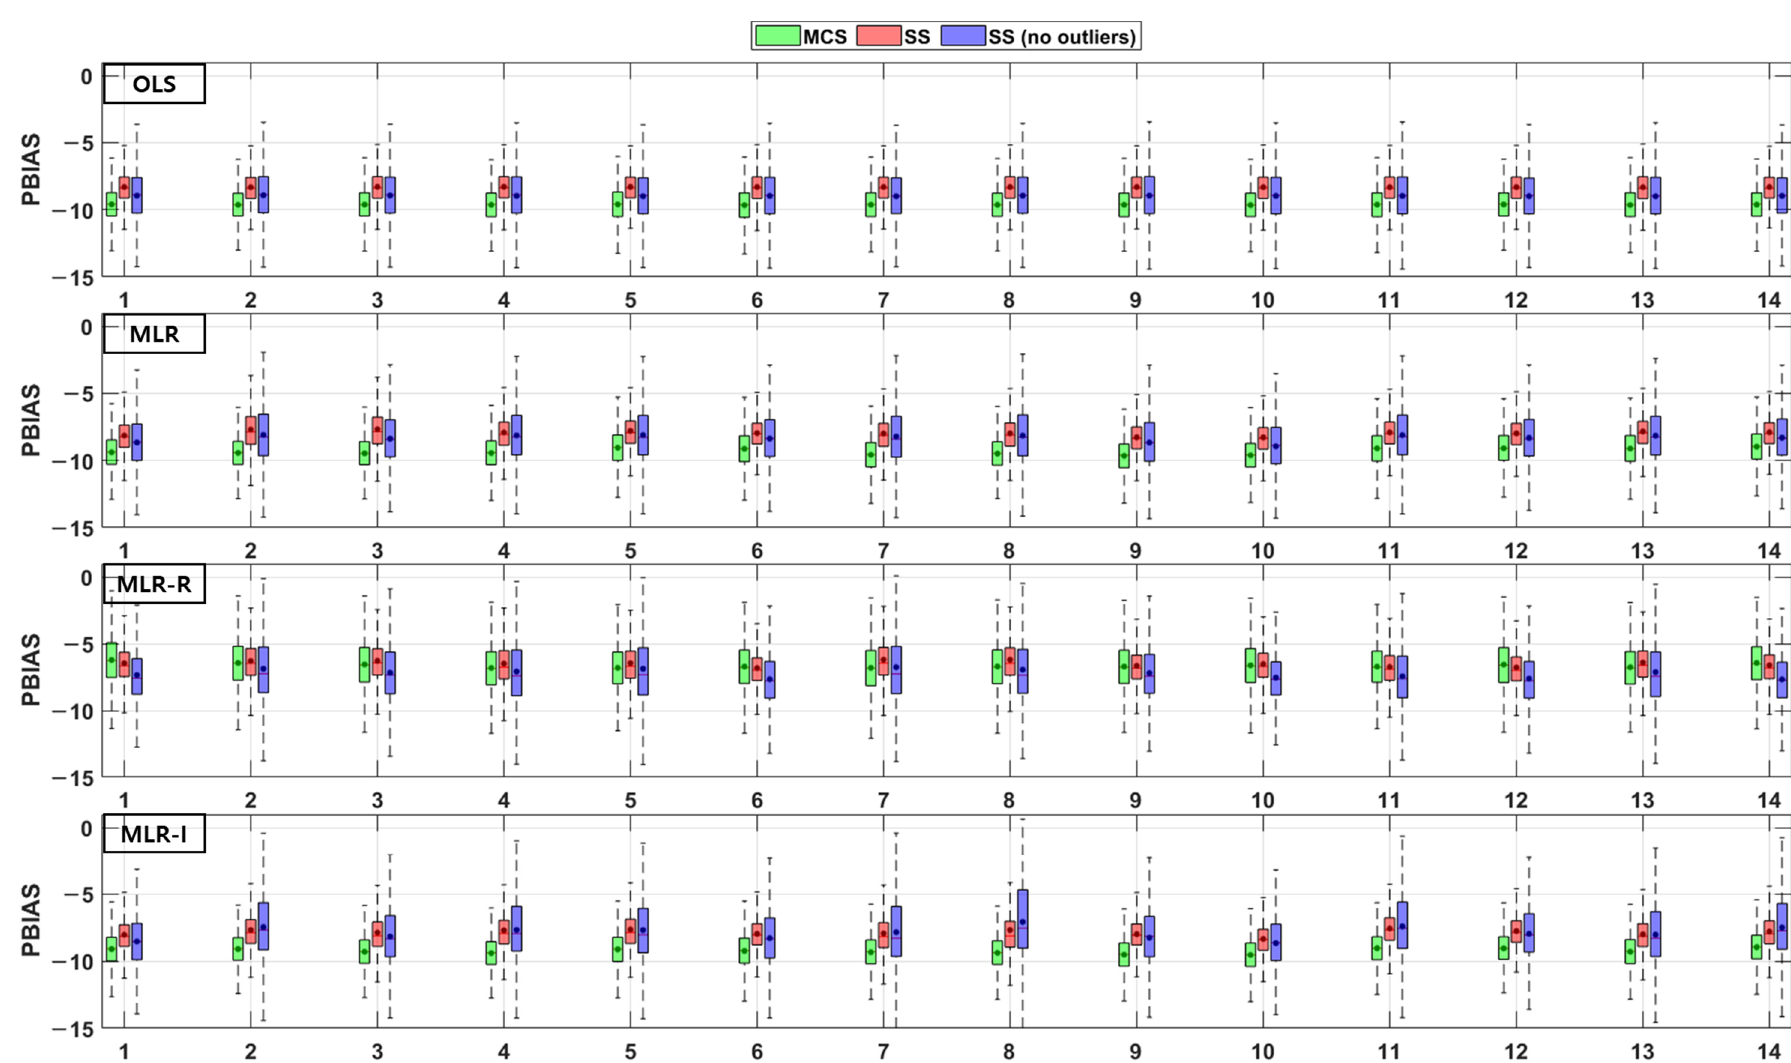
Figure 4. Error analysis (PBIAS) results of TSS removal in detention basins.